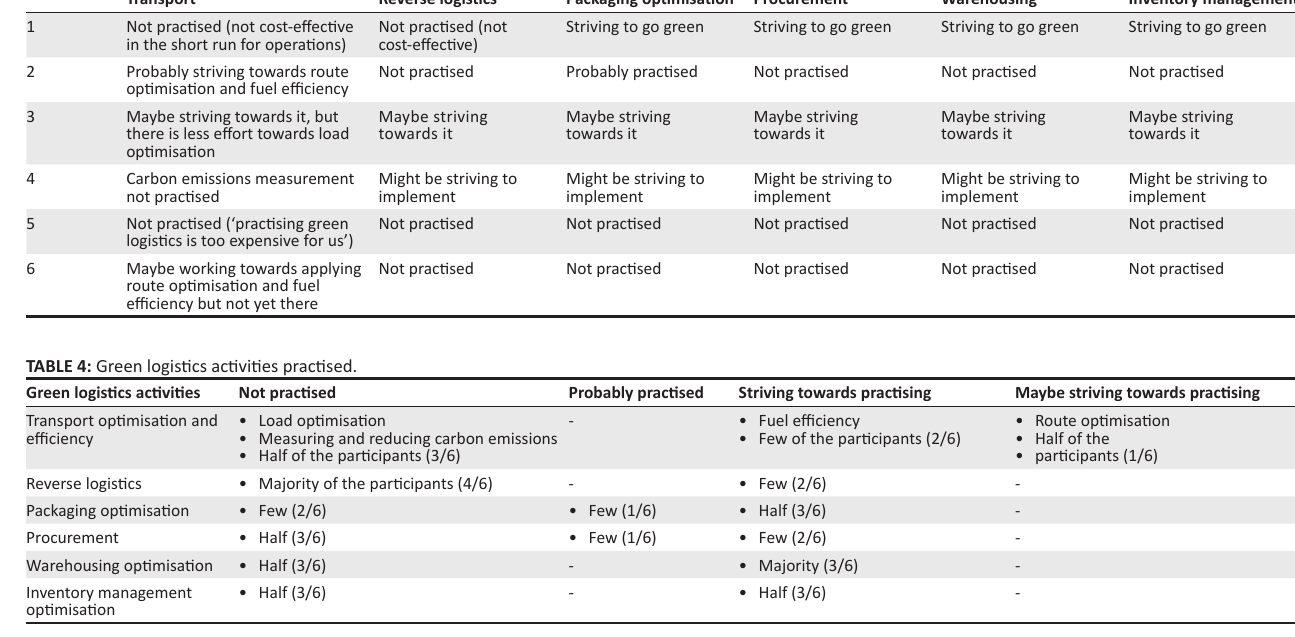
TABLE 3: Green logistics activities practised by Zimbabwean small and medium-sized enterprises. Company